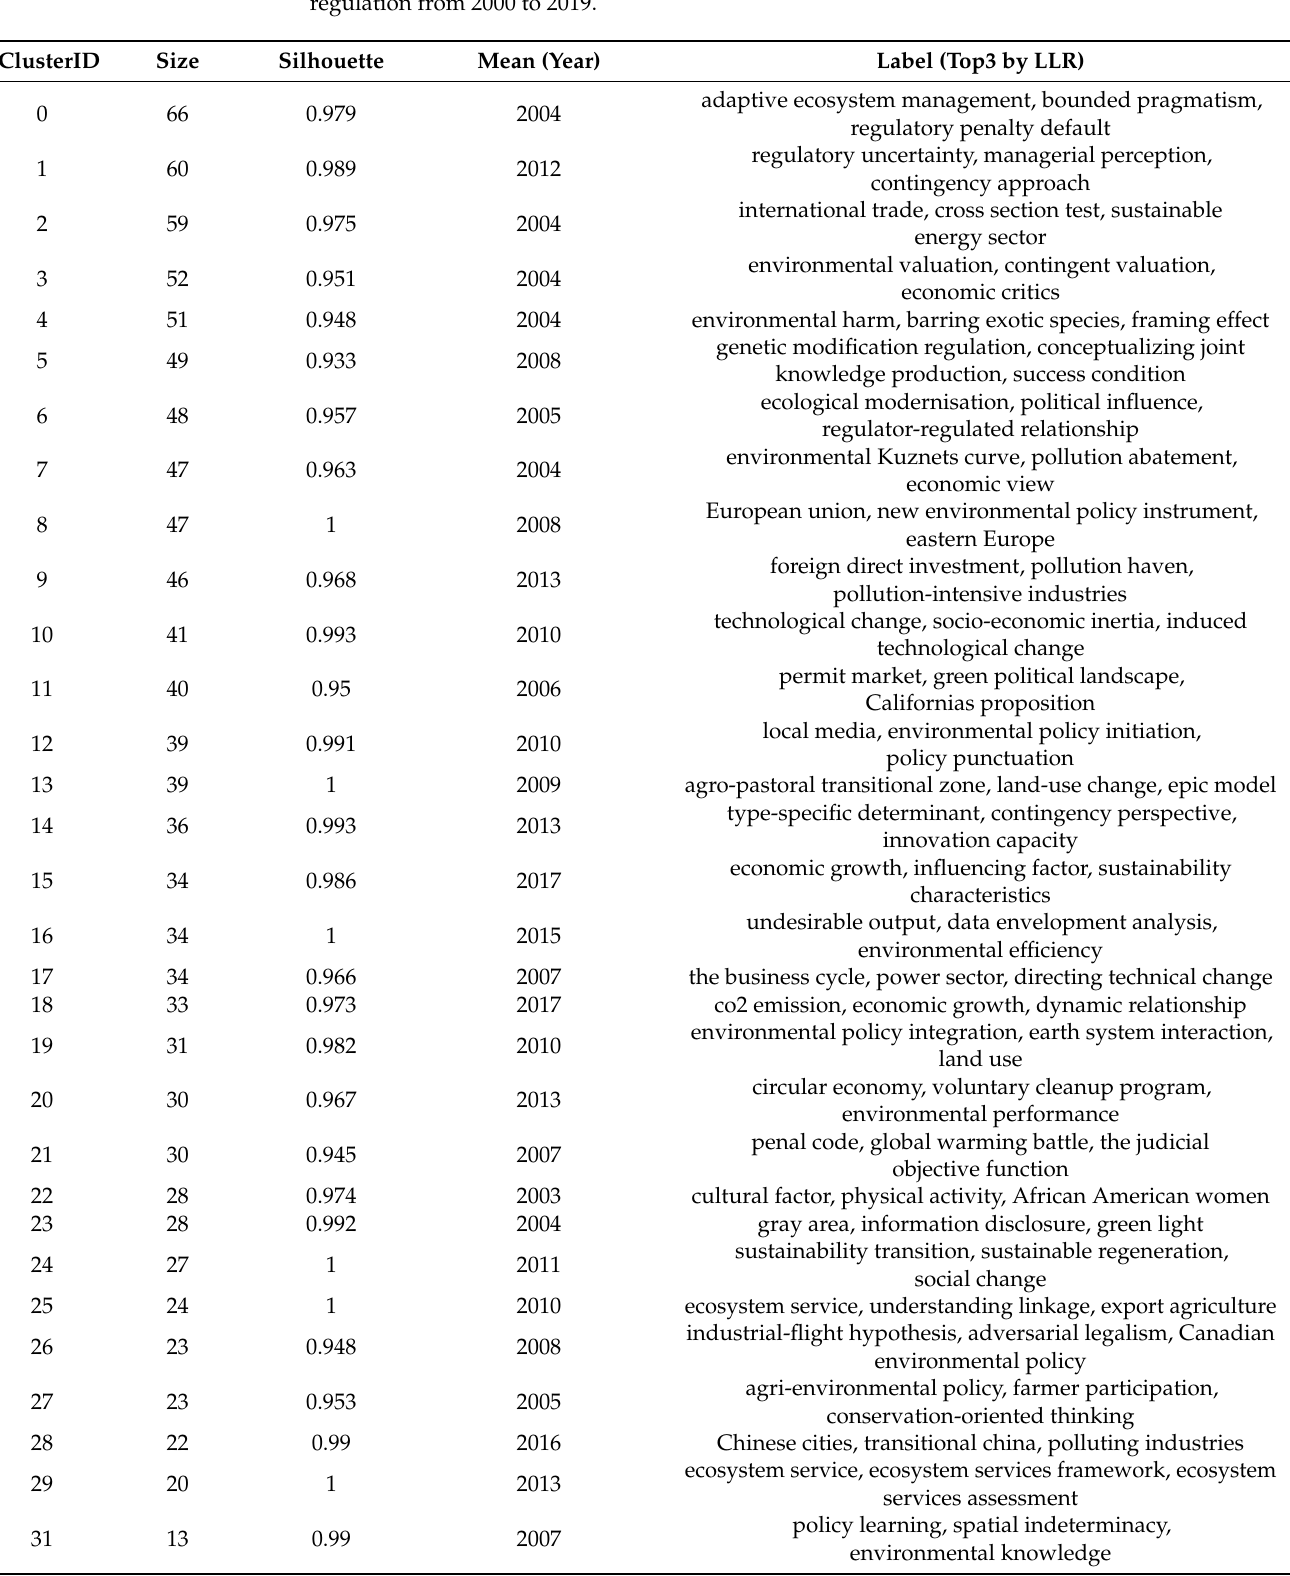
Table A1. Cluster information about the co-citation network of authors in research on environmental regulation from 2000 to